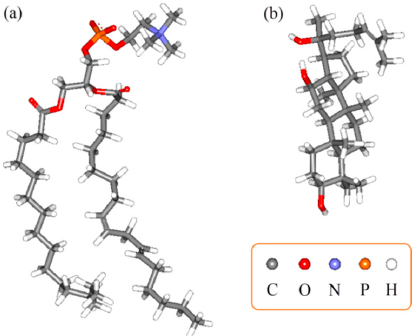
Figure 8. 3D conformation of PPD and phospholipid after docking and optimization. ( a ) PPD and phospholipid with interpolated charge surface; ( b ) H-bond interactions in the complex.